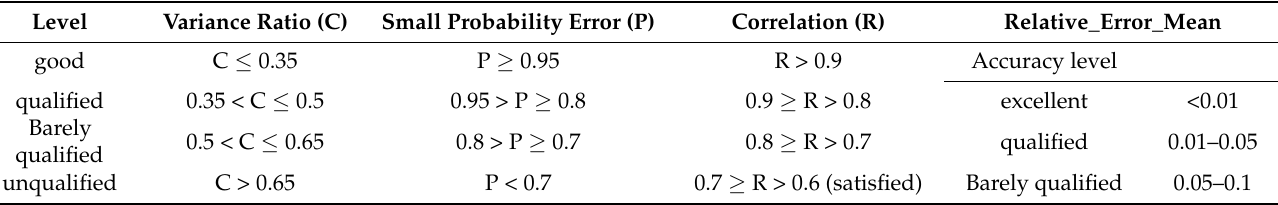
The comparison table of prediction accuracy is shown in Table 6: Table 6. The comparison table of prediction accuracy.